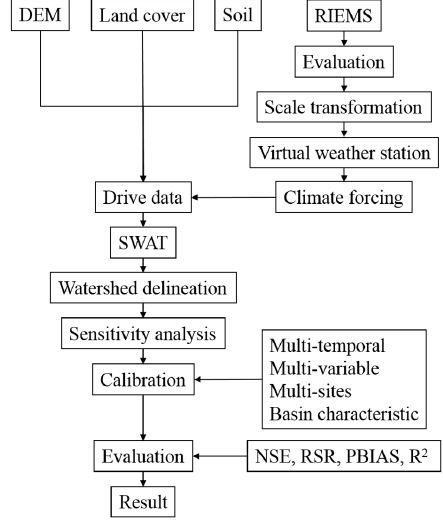
Figure 3. Diagram of the SWAT and RIEMS model coupling method.